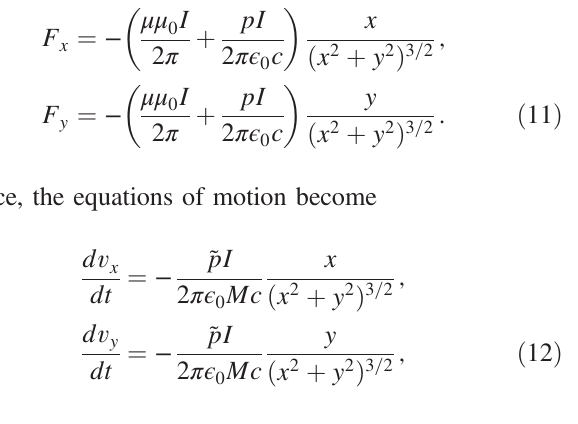
FIG. 2. Electric and magnetic field of the beam as a function of radial distance as generated by a pointlike thin-wire beam of current 1 A.